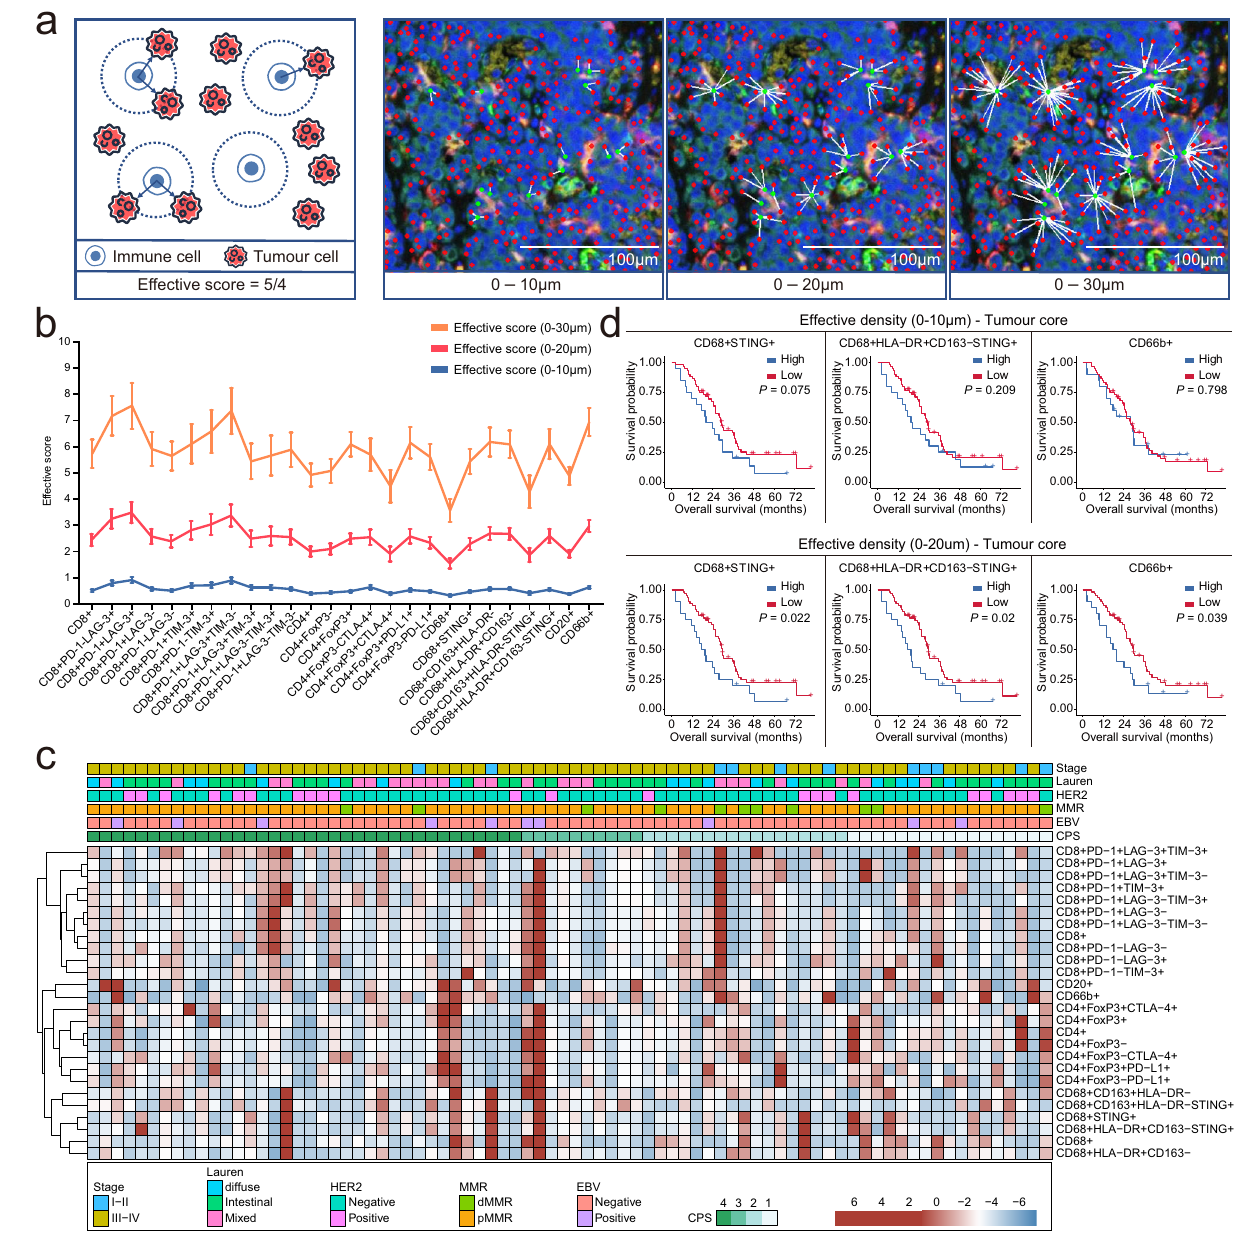
Fig. 3 | Spatial analysis of gastric cancer shows a hierarchy of organisation of tumourandimmunecells.a Illustrationofthedistanceanalysisinvolvingimmune and tumour cells. Red dots: tumour cells; green dots: immune cells. The white translucentcirclerepresentstheradius.Effectivescore=numberofpairedimmune cells and tumour cells/number of immune cells. Scale bar: 100 µ m. b The dis- tribution of the effective score of tumour-in fi ltrating immune cell (TIIC) popula- tions in the tumour core in 10-, 20- and 30 µ m increments ( n =80). Error bars represent mean±SEM. c Effective score of TIICs in patients grouped by gastric